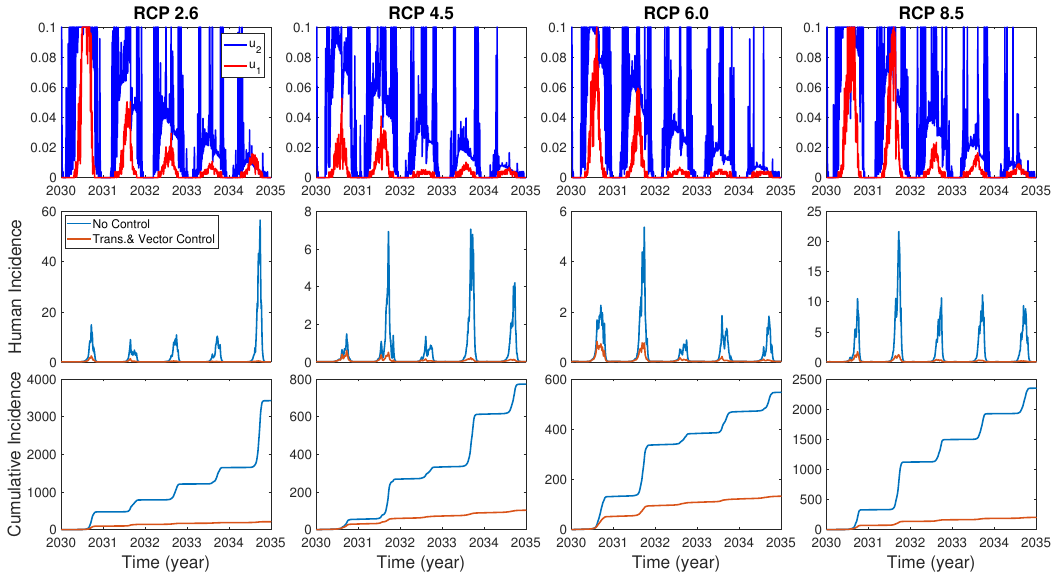
Figure 9. The effect of control of β hv , β vh and µ v on the incidences and the optimal control functions u 1 , u 2 .